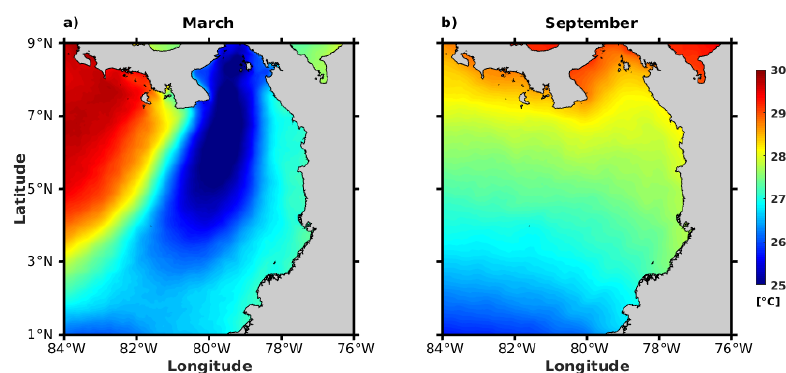
Figure 8. Climatology (2002–2016) of sea surface temperature (in color scale) for ( a ) March and ( b ) September. Red (blue) shading represents the regions with high (low) sea surface temperature.